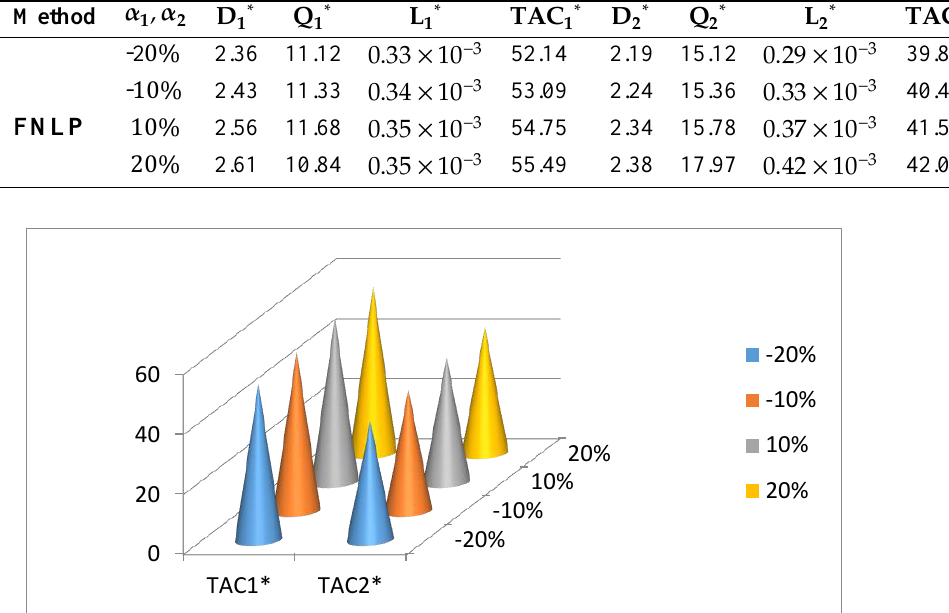
Fig. 3. Minimizing cost of both items for different values of 𝛂 𝟏 , 𝛂 𝟐